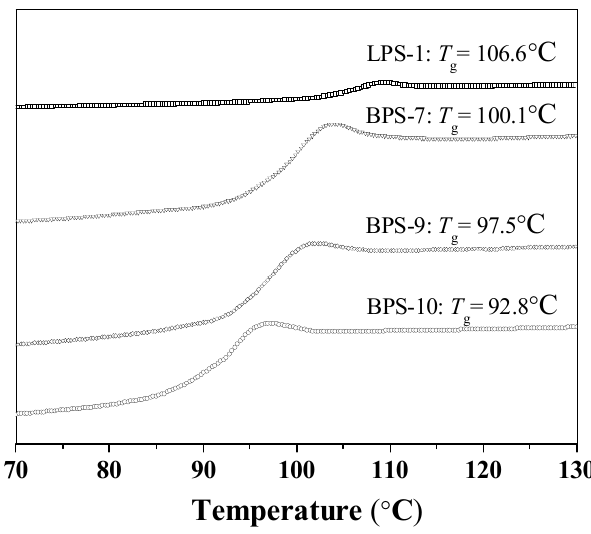
Figure 6. Differential scanning calorimetry (DSC) curves of the linear and branched polystyrenes.